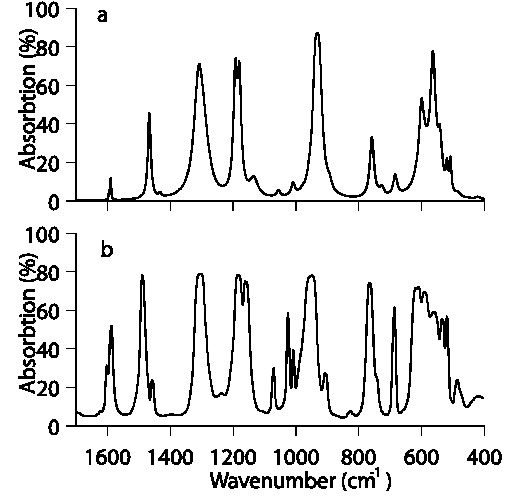
Figure 8. Calculated (a) and experimental (b) IR spectra of phenyl dichlorophosphate. Theoretical IR spectrum of mixture was obtained for x(±sc)=55% and